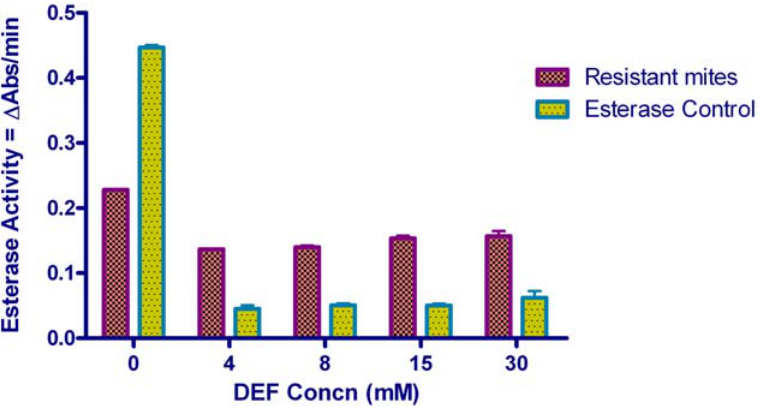
Figure 2. Results of in-vitro enzyme inhibition by synergists/inhibitors (30 mM). A. Esterase activity in resistant and sensitive scabies mites in the presence or absence of inhibitor (PBO, DEF and DEM). B. GST activity in resistant and sensitive mites in the presence or absence of inhibitor (PBO, DEF and DEM). C. Cytochrome P450 activity in the presence or absence of inhibitor (PBO, DEF and DEM). *Error bars represent SEM.